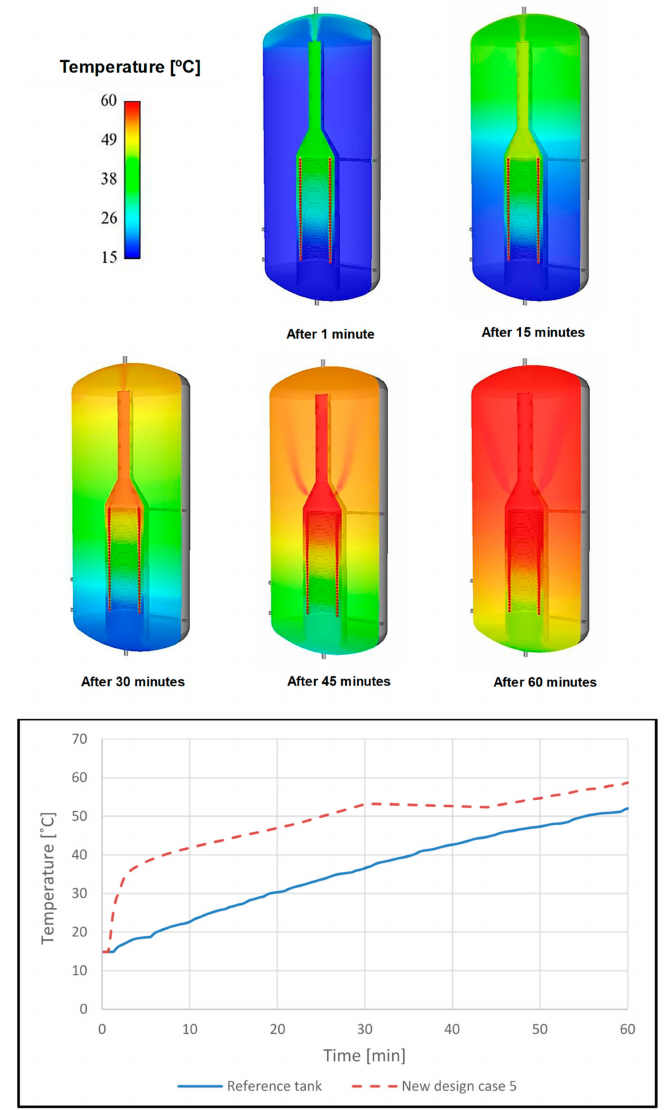
Figure 11. Evolution of the temperature field in simulation 5 and comparison of DHW temperatures with the reference case (average temperature at the DHW